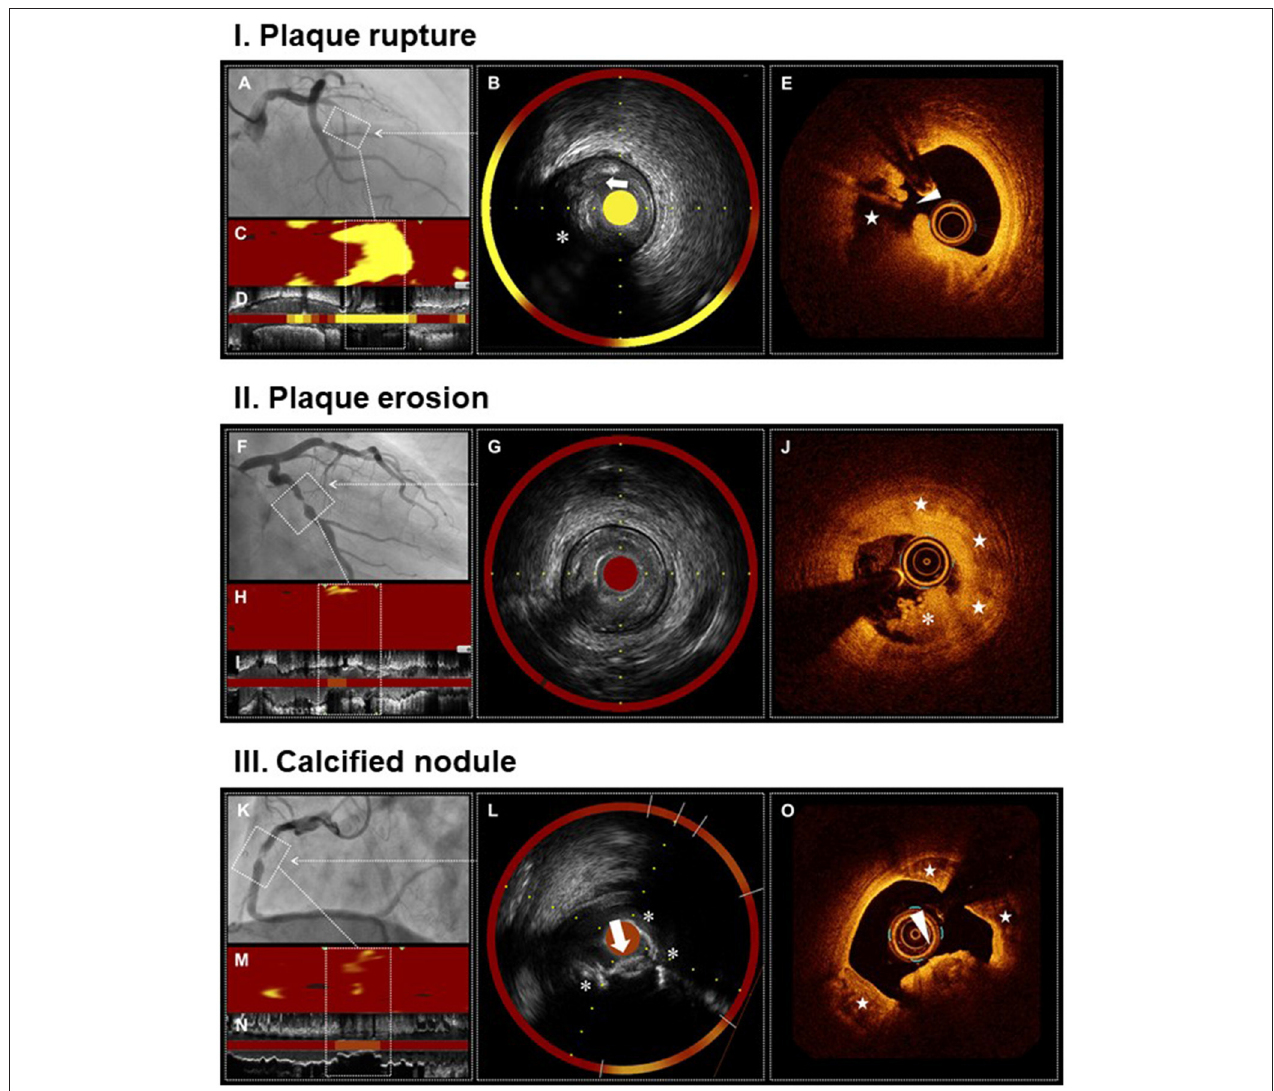
FIGURE 1 | Multimodality imaging of plaque rupture, plaque erosion, and calcified nodule. Plaque rupture (I) Angiogram shows occlusion of proximal LAD, the culprit lesion of STEMI (A) . IVUS demonstrates ulceration (arrow) with a recess on the surface of attenuated plaque (asterisk) (B,D) . NIRS identifies a large lipid content (maxLCBI4mm = 920) (B–D) . OCT reveals plaque rupture characterized by a fibrous cap disruption (arrowhead) and a cavity (star) formation inside the plaque (E) . Plaque erosion (II) Angiogram shows severe stenosis in mid LCX, the culprit lesion of STEMI (F) . IVUS demonstrates the absence of plaque ulceration (G,I) .